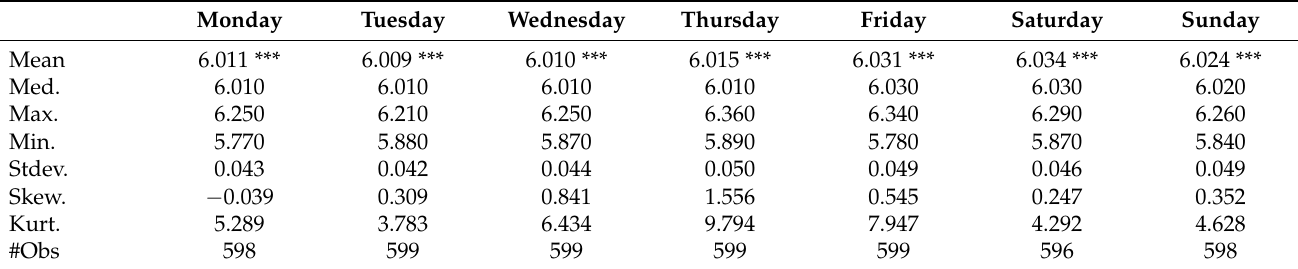
Table 9. Twitter Happiness Index across weekdays